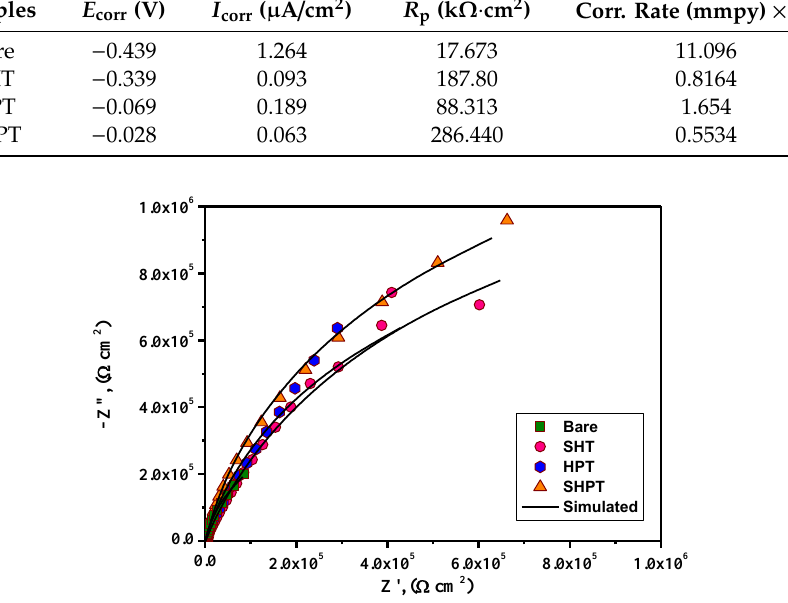
Figure 6. Nyquist curves of treated specimens in SBF medium.